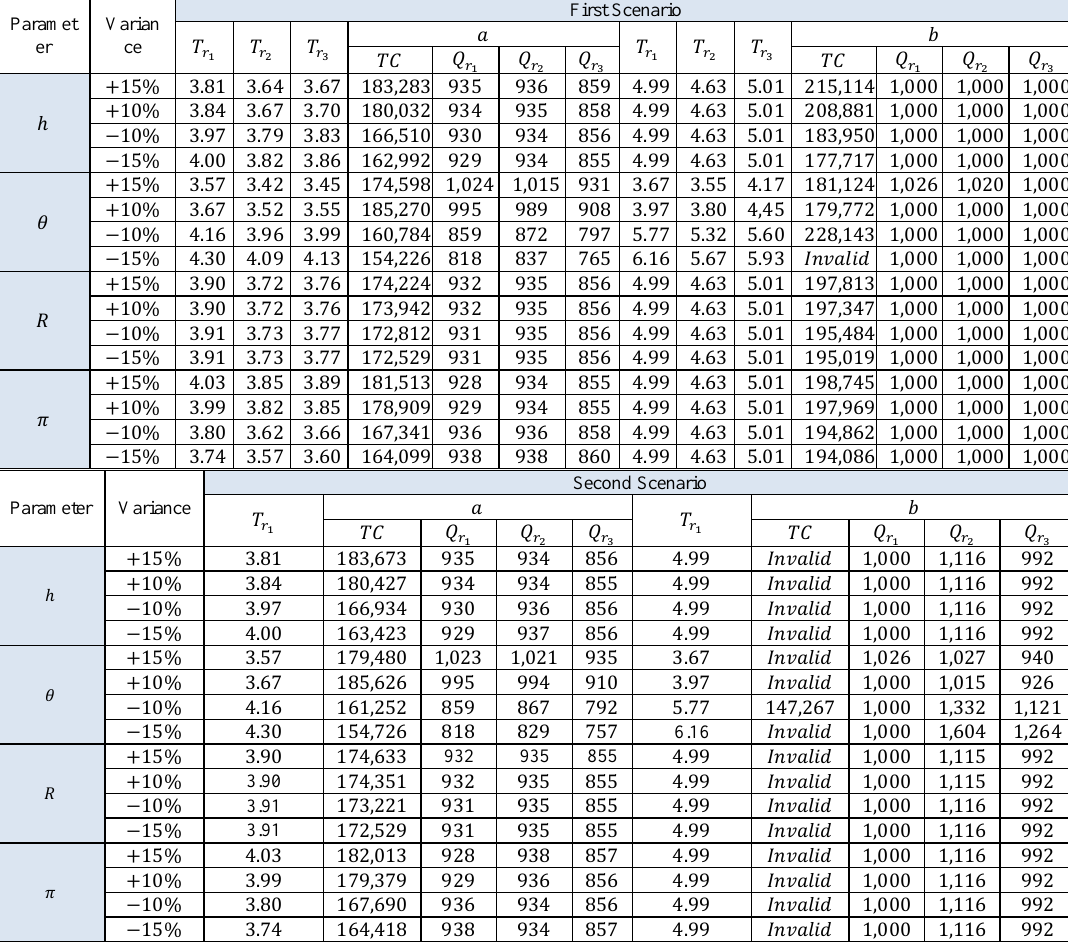
Table 4. Sensitivity